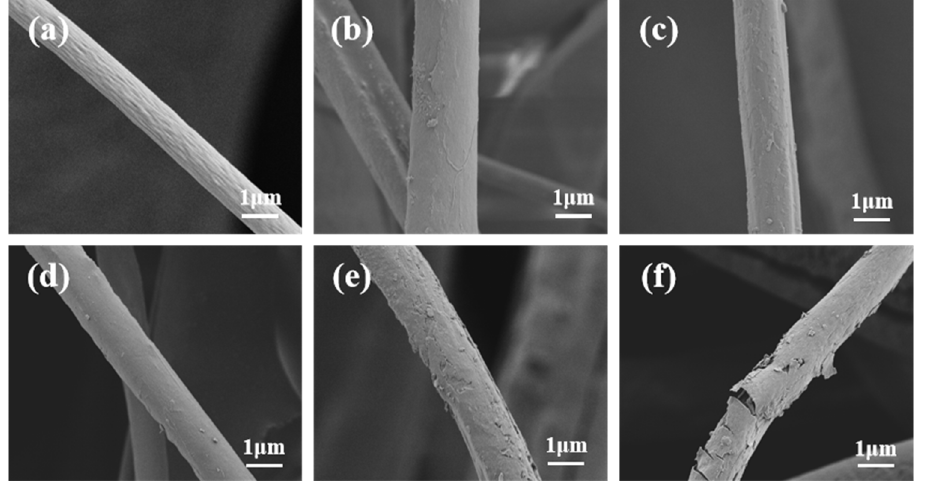
Figure 8. SEM images of centrifugal spinning CA fiber before and after plasma treatment: ( a ) control CA; ( b ) 3 min, 40 W; ( c ) 5 min, 60 W; ( d ) 8 min, 80 W; ( e ) 10 min, 80 W; ( f ) 10 min, 100 W.